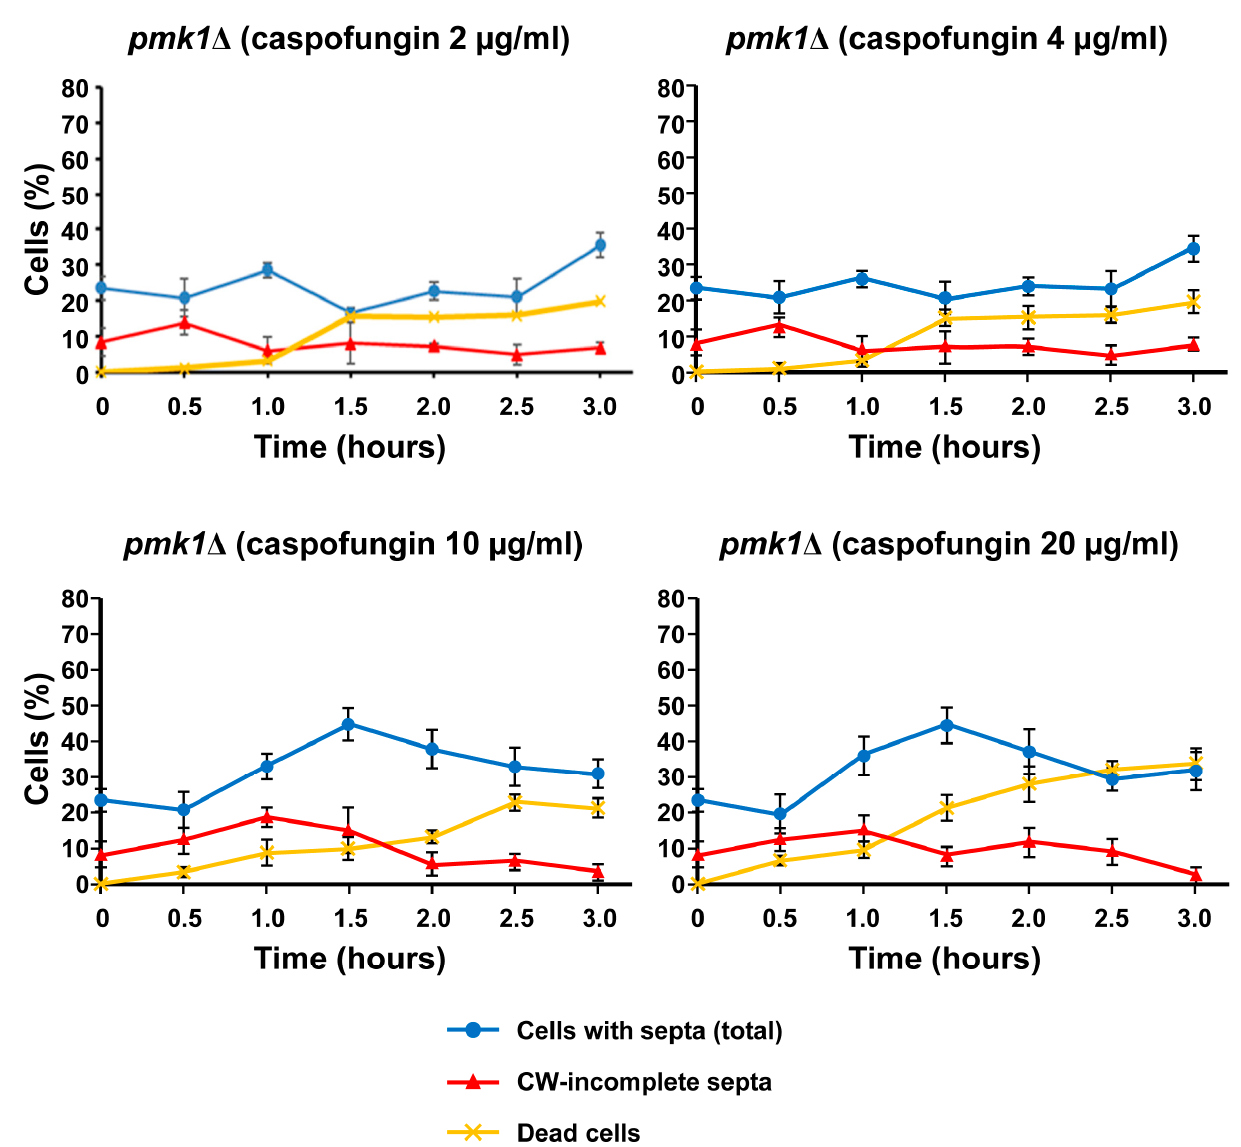
Figure 9. Percentages of the total pmk1 ∆ dead cells (yellow line), CW ‐ stained total septa (blue line), and CW ‐ incomplete septa (red line) either in the absence (time 0 h) or in the presence of sublethal (2 and 4 μ g/mL) and lethal (10 and 20 μ g/mL) concentrations of caspofungin. Cells were grown and imaged at the indicated times and drug concentrations as in Figure 8. Error bars indicate standard